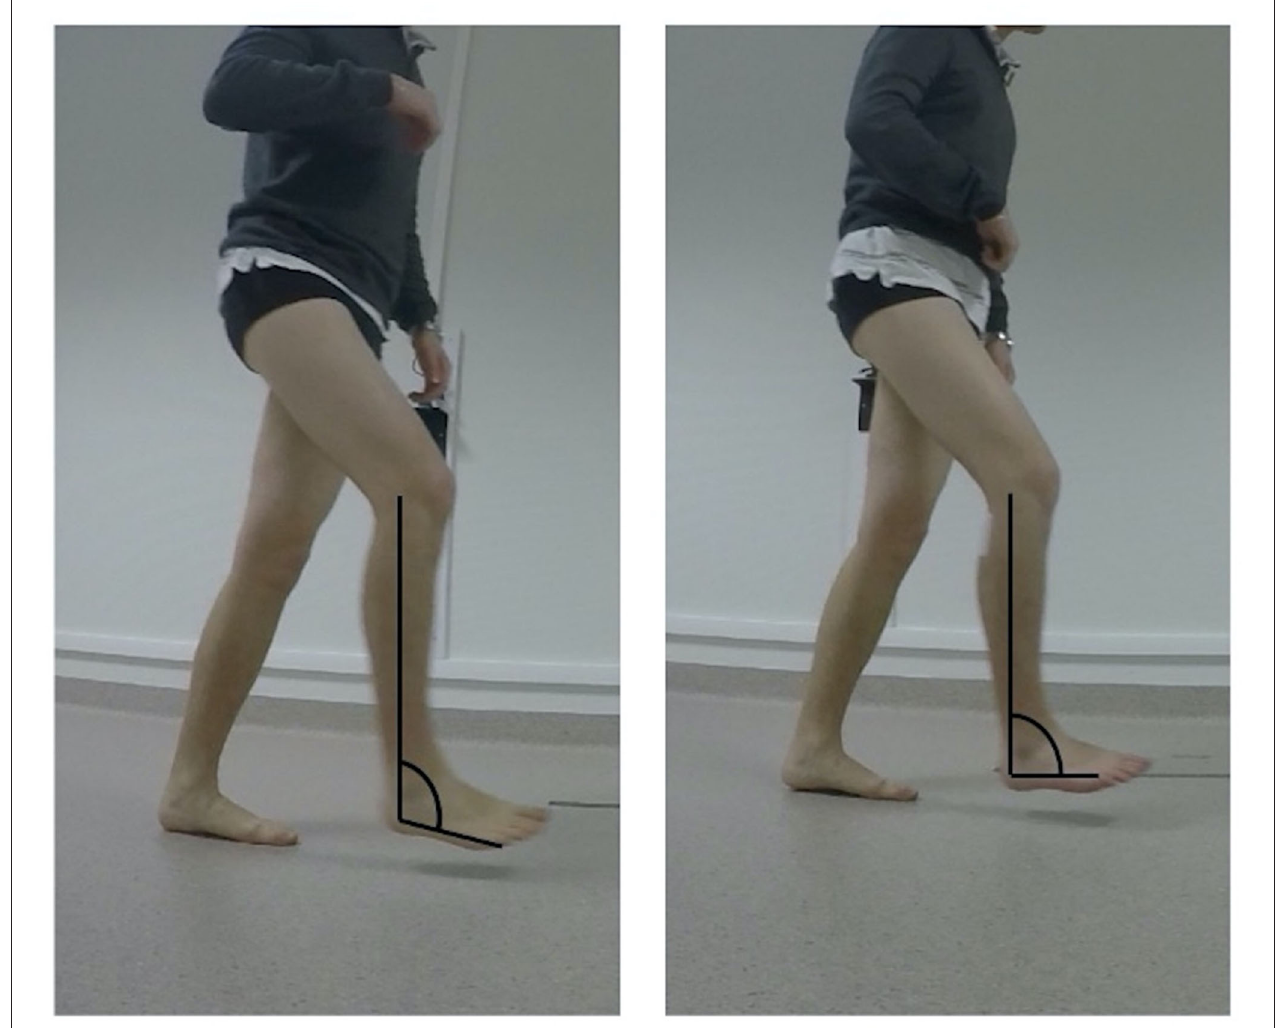
FIGURE 1 | Illustration of improved ankle dorsiflexion confirmed by pre- (on the left) and post- (on the right) motor nerve block comparison in the sagittal plane